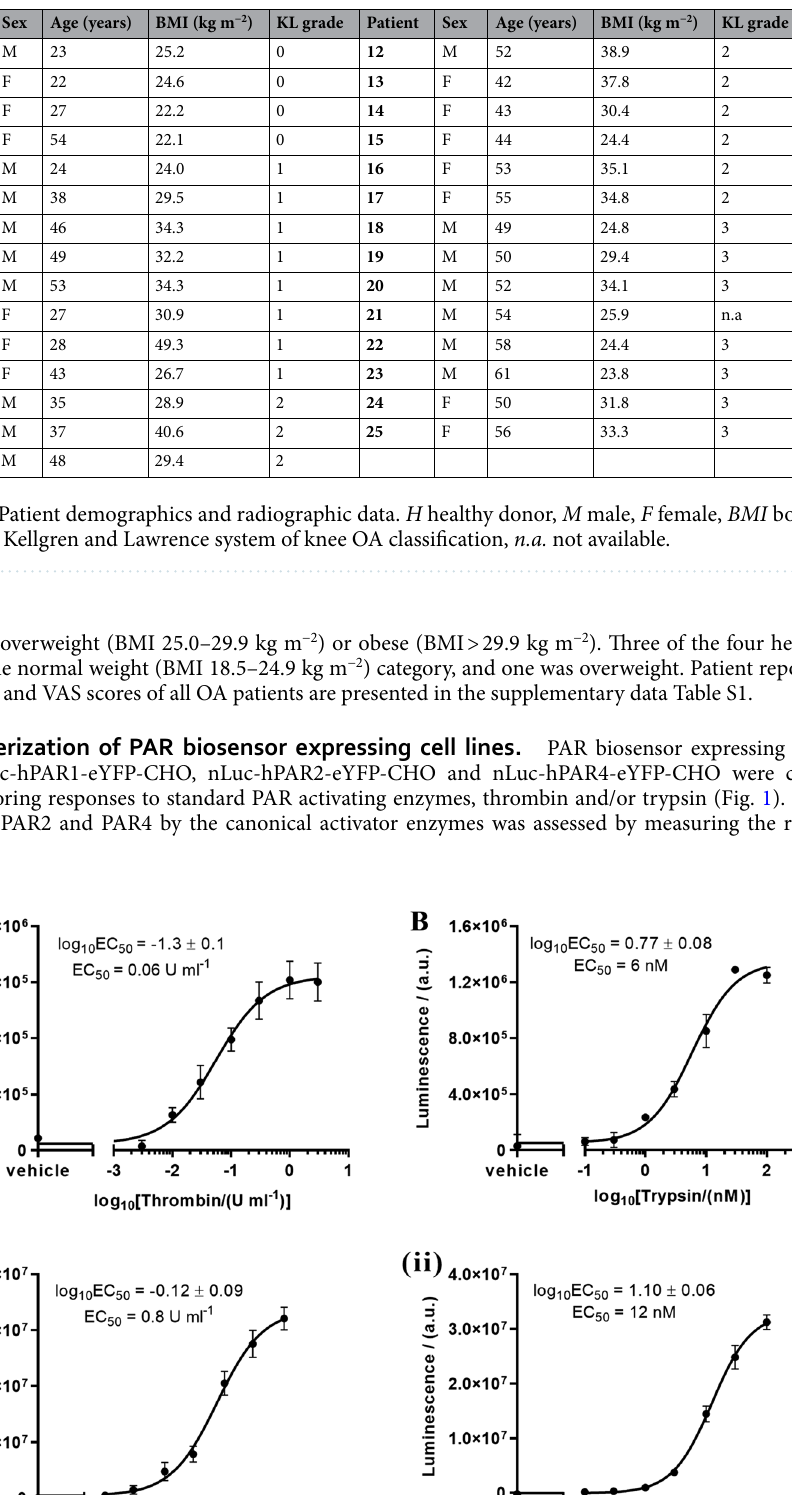
Figure 1. Characterization of PAR biosensor expressing reporter cell lines, ( A ) nLuc-hPAR1-eYFP-CHO response to thrombin (0.003–3 U ml −1 ), ( B ) nLuc-hPAR2-eYFP-CHO response to trypsin (0.1–100 nM), and (C) nLuc-hPAR4-eYFP-CHO response to ( i ) thrombin (0.01–10 U ml −1 ) and ( ii ) trypsin (0.1–100 nM). Each data point on the concentration-effect curve represents the mean ± SEM of at least three independent experiments ( N = 3–4) performed in